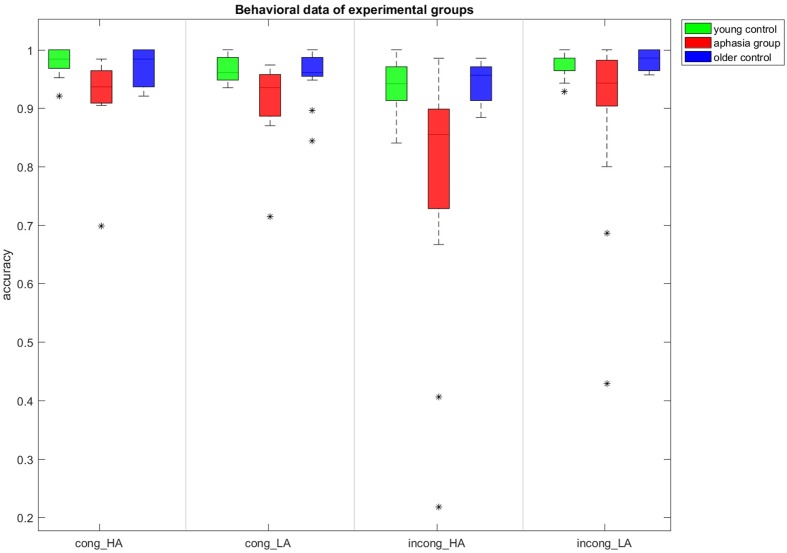
Average performance for each subject group in each sentence group. The error bars represent the minimum and maximum performance without outliers (asterisks). The horizontal line in the middle of the bar represents the median and the lower and upper limits of the boxes indicate first and third quartiles respectively.